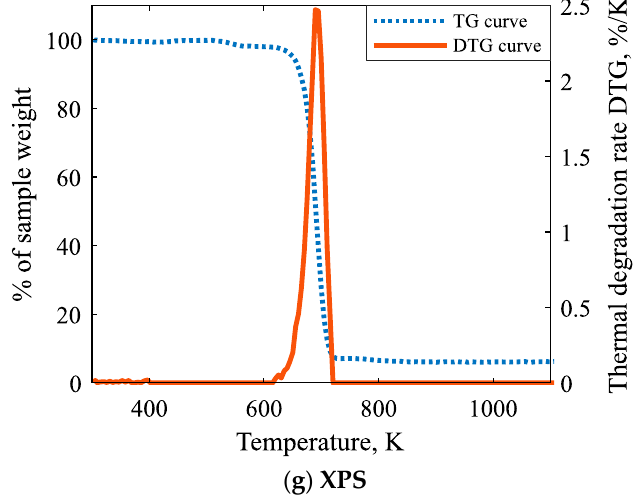
Figure 1. TG and DTG curves of polymer samples at 20 K/min heating rate: ( a ) HDEPS; ( b ) LDEPS; ( c ) EVA; ( d ) LDPU; ( e ) HDPU; ( f ) PE; ( g ) XPS.